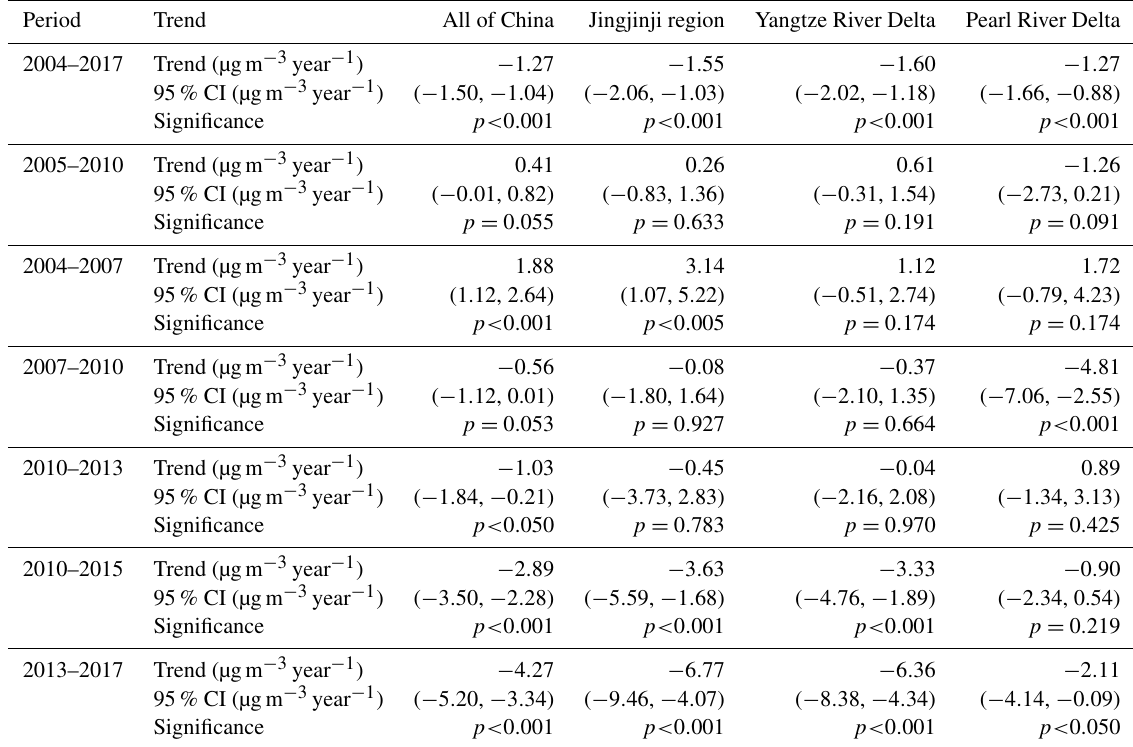
Table 2. Trends and 95% confidence intervals (CIs) of PM 2 . 5 concentrations for all of China and the Jingjinji, Yangtze River Delta, and Pearl River Delta regions from 2004 to 2017. Period Trend All of China Jingjinji region Yangtze River Delta Pearl River Delta 2004–2017 Trend (µgm − 3 year − 1 ) Significance p< 0 . 001 p< 0 . 001 p< 0 . 001